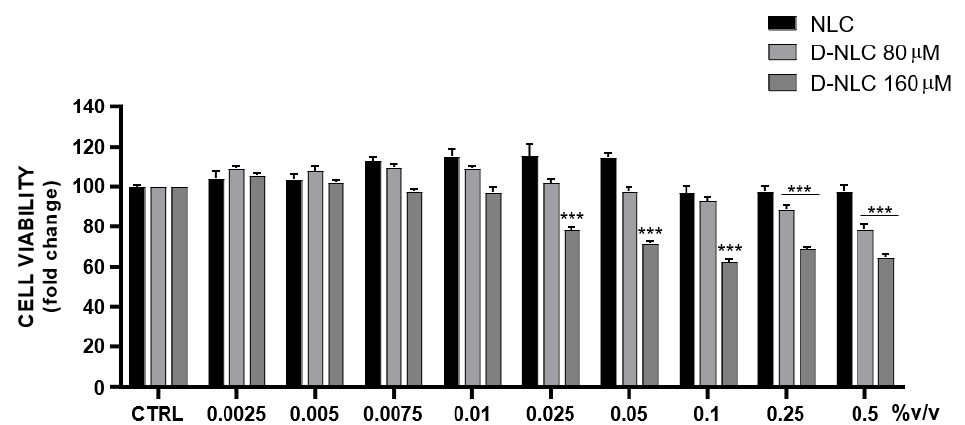
Figure 13. Evaluation of cytotoxicity of formulations of NLCs empty and loaded with different concentrations of diosmin (80–160 µ M) on the ARPE-19 cell line (*** p < 0.0005 vs. NLCs).